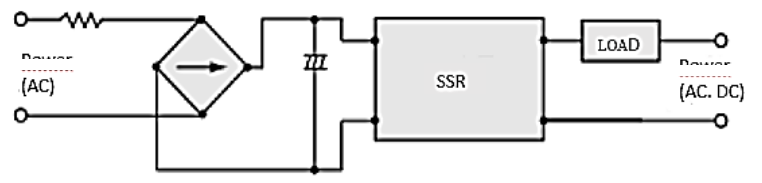
Figure A5. Connection diagram for solid state relay [9].